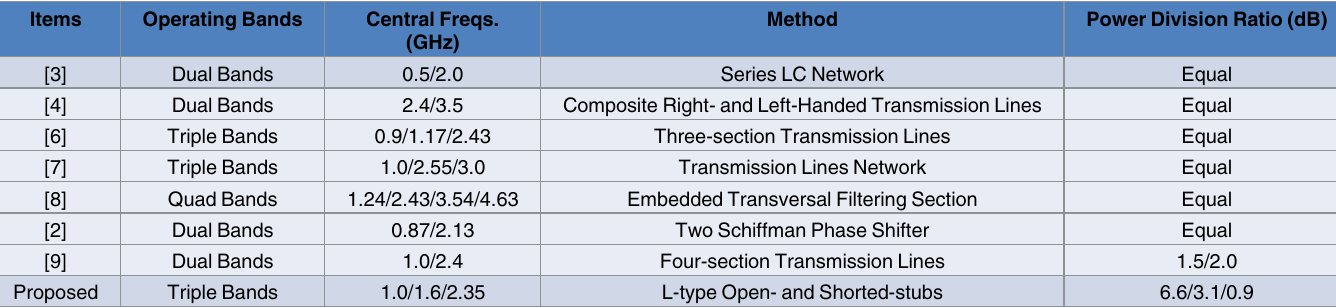
Table 1. Comparison of proposed power divider with existing